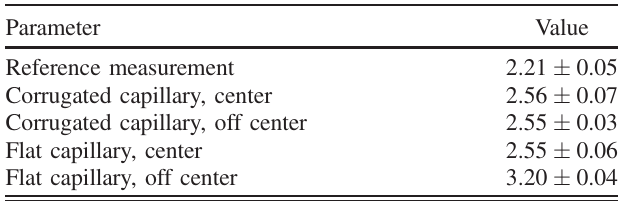
TABLE III. Measured charge